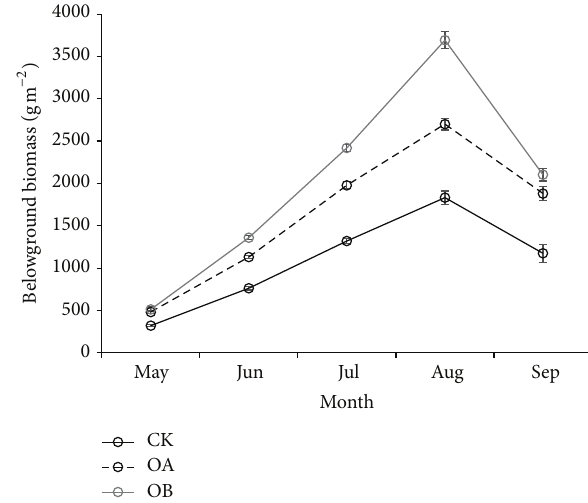
Figure 5: Growing season variations in belowground plant biomass corresponding to the warming treatments.